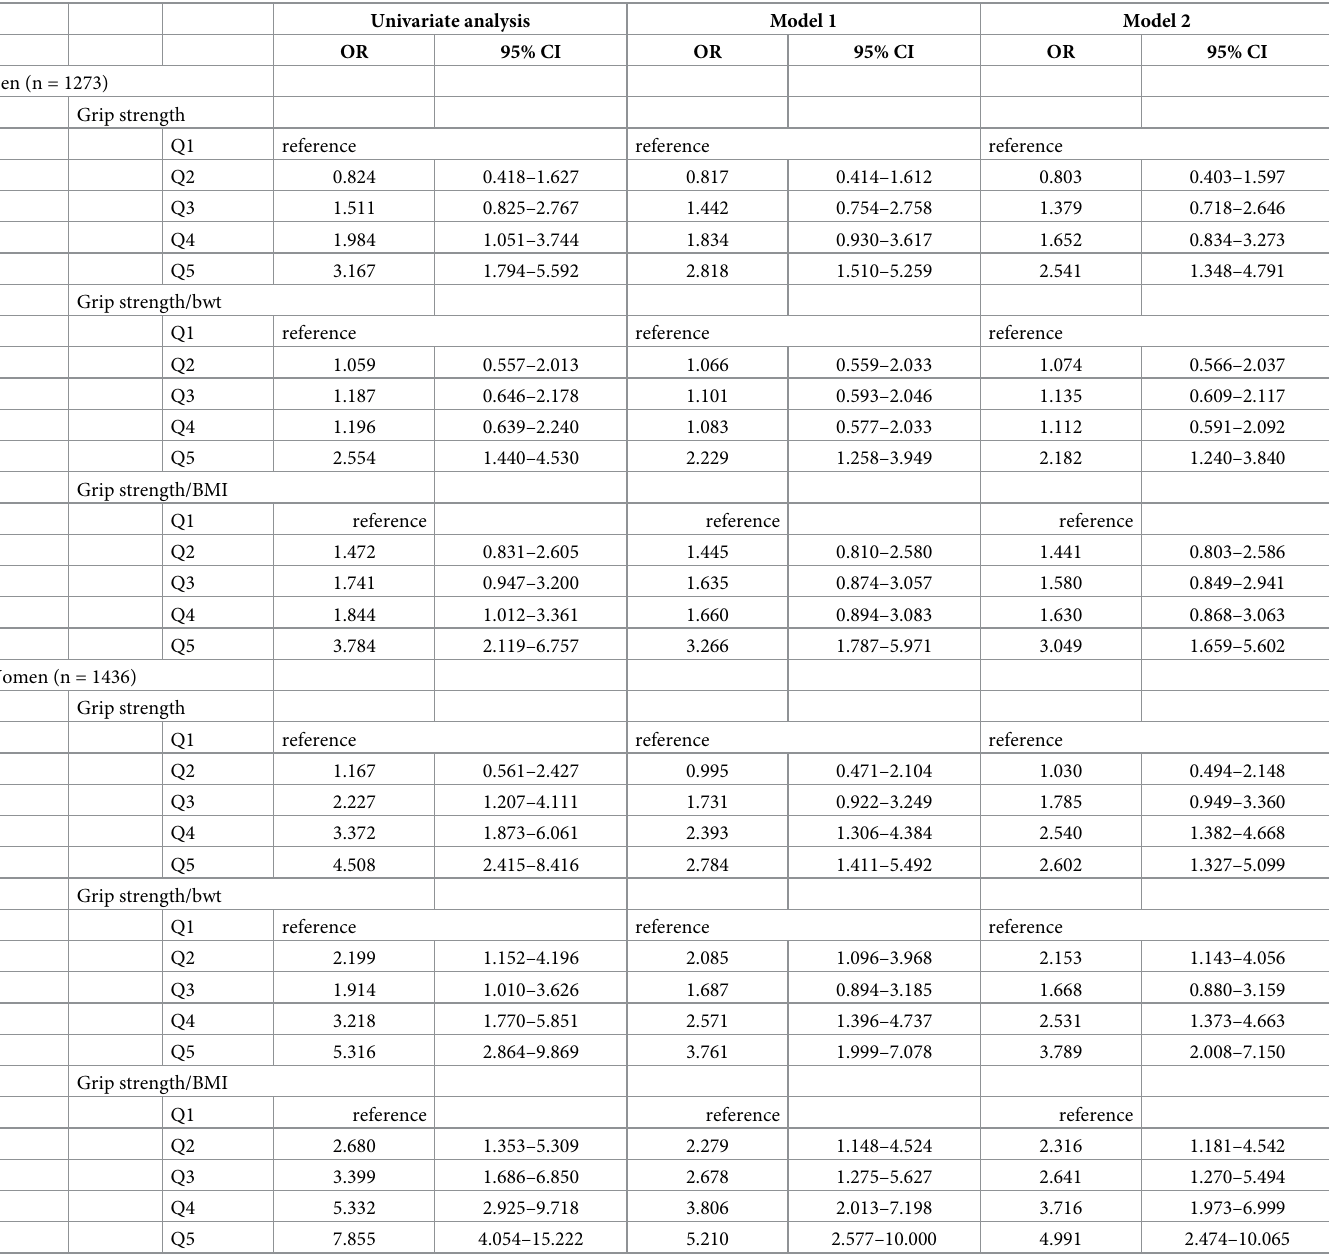
Table 5. Odds ratios of each quintile of grip strength and normalized grip strength for poor quality of